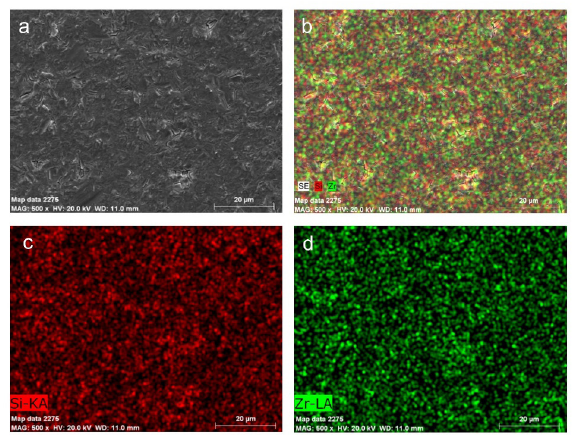
Figure 1: SEM images of the zirconium/silica coating (a) and EDX maps of the zirconium and silicon atoms distributions (b), silicon atoms distribution (c), zirconium atoms distribution